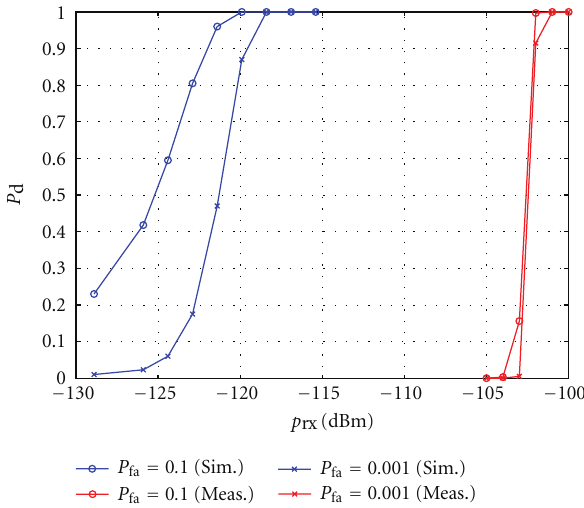
Figure 13: Simulation and measurement results for PAL-D/K ( t sense =